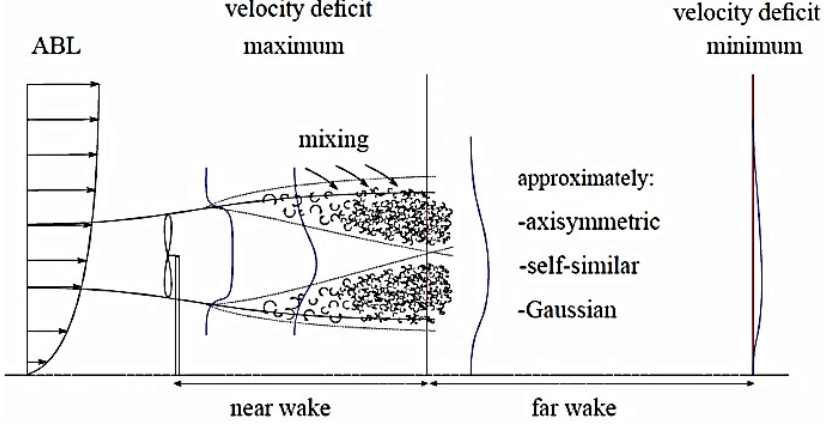
Figure 1. A schematic of the wake characteristics of a wind turbine [2].